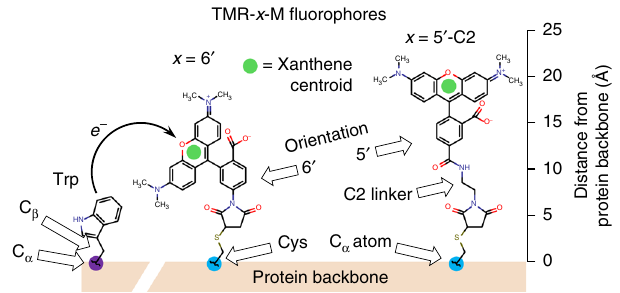
Fig. 1 Principle of distance-encoding photoinduced electron transfer (DEPET). A tryptophan (Trp) residue is shown attached to the protein backbone, along with two Cys-conjugated tetramethylrhodamine maleimide (TMRM) fl uorophores of different length. Trp residues are potent quenchers of TMRM fl uorescence (Supplementary Figure 1 and ref. 16 ), by the photoinduced electron transfer (PET) process: while the TMRM fl uorescent moiety (xanthene, green circle) is in the excited singlet state, contacting a Trp side-chain triggers an electron transfer reaction, preventing fl uorescence emission 8,9 . In this work, we show how we can extract distances and distance changes directly associable with protein structure and function (Cys C α (cyan circle) — Trp C α (purple circle) and Cys C α — Trp C β (red circle) atoms, respectively), by measuring the Trp- induced PET quenching of TMRM fl uorophores of different length. We have implemented DEPET in (i) the activation transition of the human BK channel voltage-sensing domain, in conducting channels expressed in a cell and (ii) synthetic polyproline peptide length standards in (W203) at the extracellular fl ank of helix S4 16,27,28 . In fact, when short TMR-6 ′ -M label was used, its fl uorescence increased upon